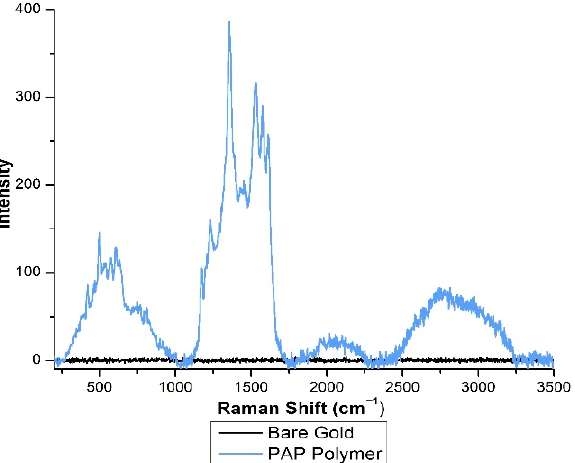
Figure 7. Raman spectra of PAP polymerized on a gold wafer (blue) and a bare gold wafer (black).